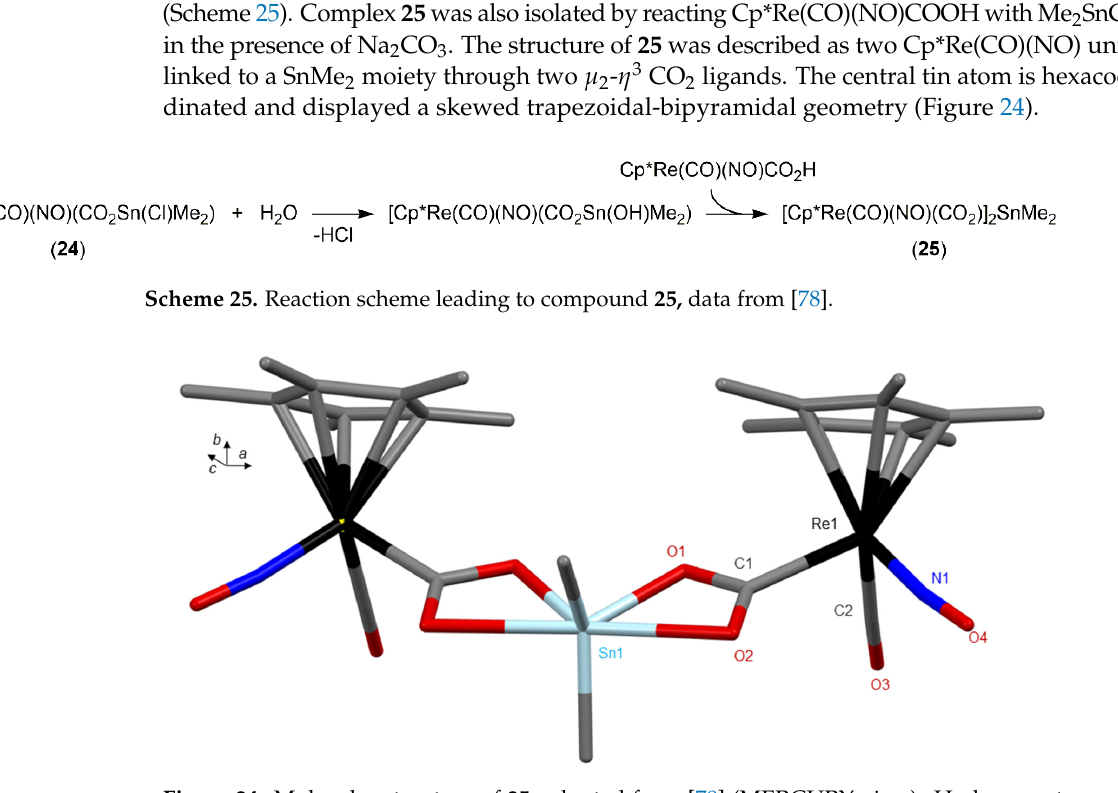
Figure 24. Molecular structure of 25 , adapted from [78] (MERCURY view). Hydrogen atoms are omitted for clarity (Sn light blue, O red, N dark blue, Re black, C grey).